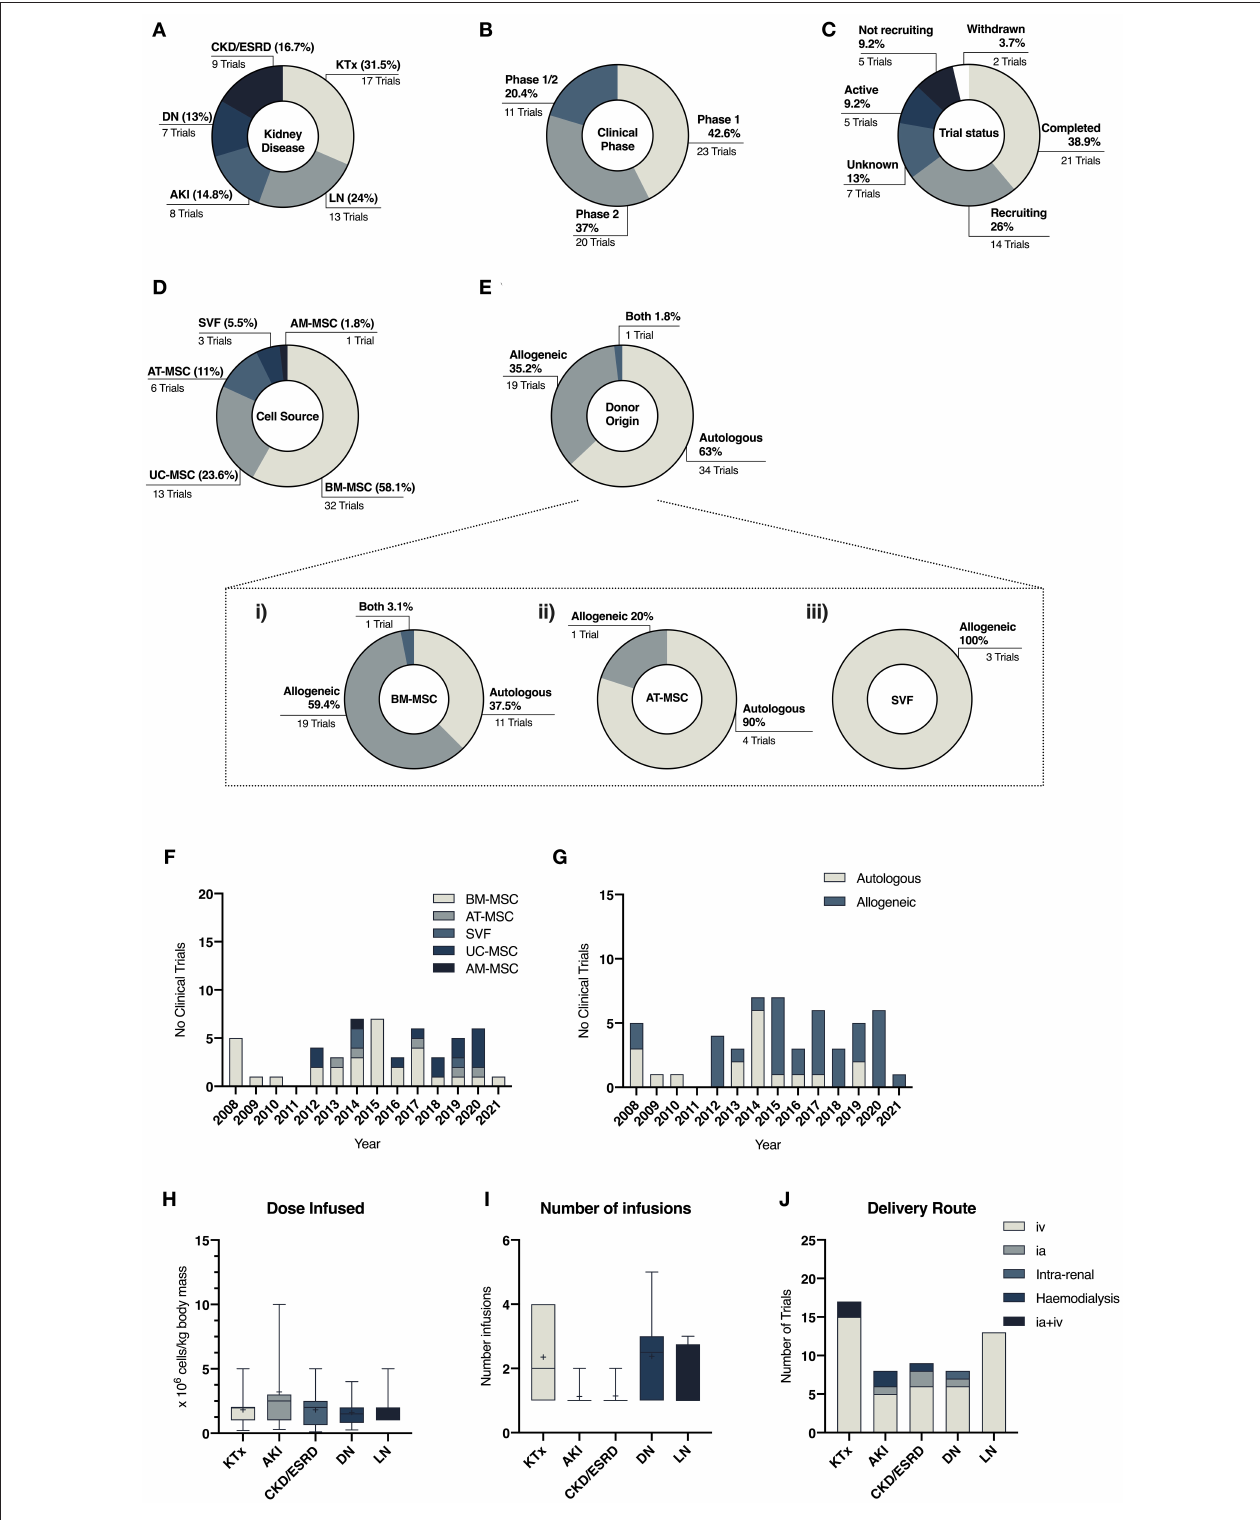
FIGURE 3 | Descriptive data related to clinical trials in kidney diseases comparing the number of trials per disease (A) , clinical phase of the studies (B) and their status (C) . (D,E) Illustrate the heterogeneity of cell and donor source across all studies, while (F,G) depicts the change of cell and donor source preferences over the years. (H–J) illustrate protocol differences across different disease settings related to dose of MSC infused (H), frequency of infusions (I) and choice of delivery route (J) .